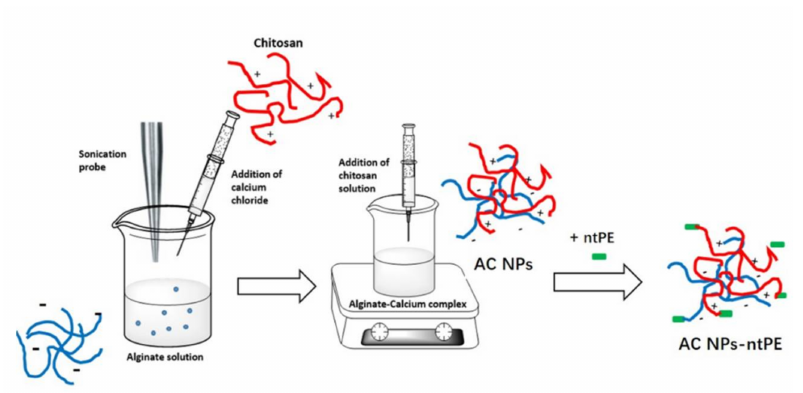
Figure 1. Overview illustration of alginate-chitosan (AC) nanoparticles (NPs) and stage of chemical coupling of non-toxic Pseudomonas aeruginosa exotoxin A